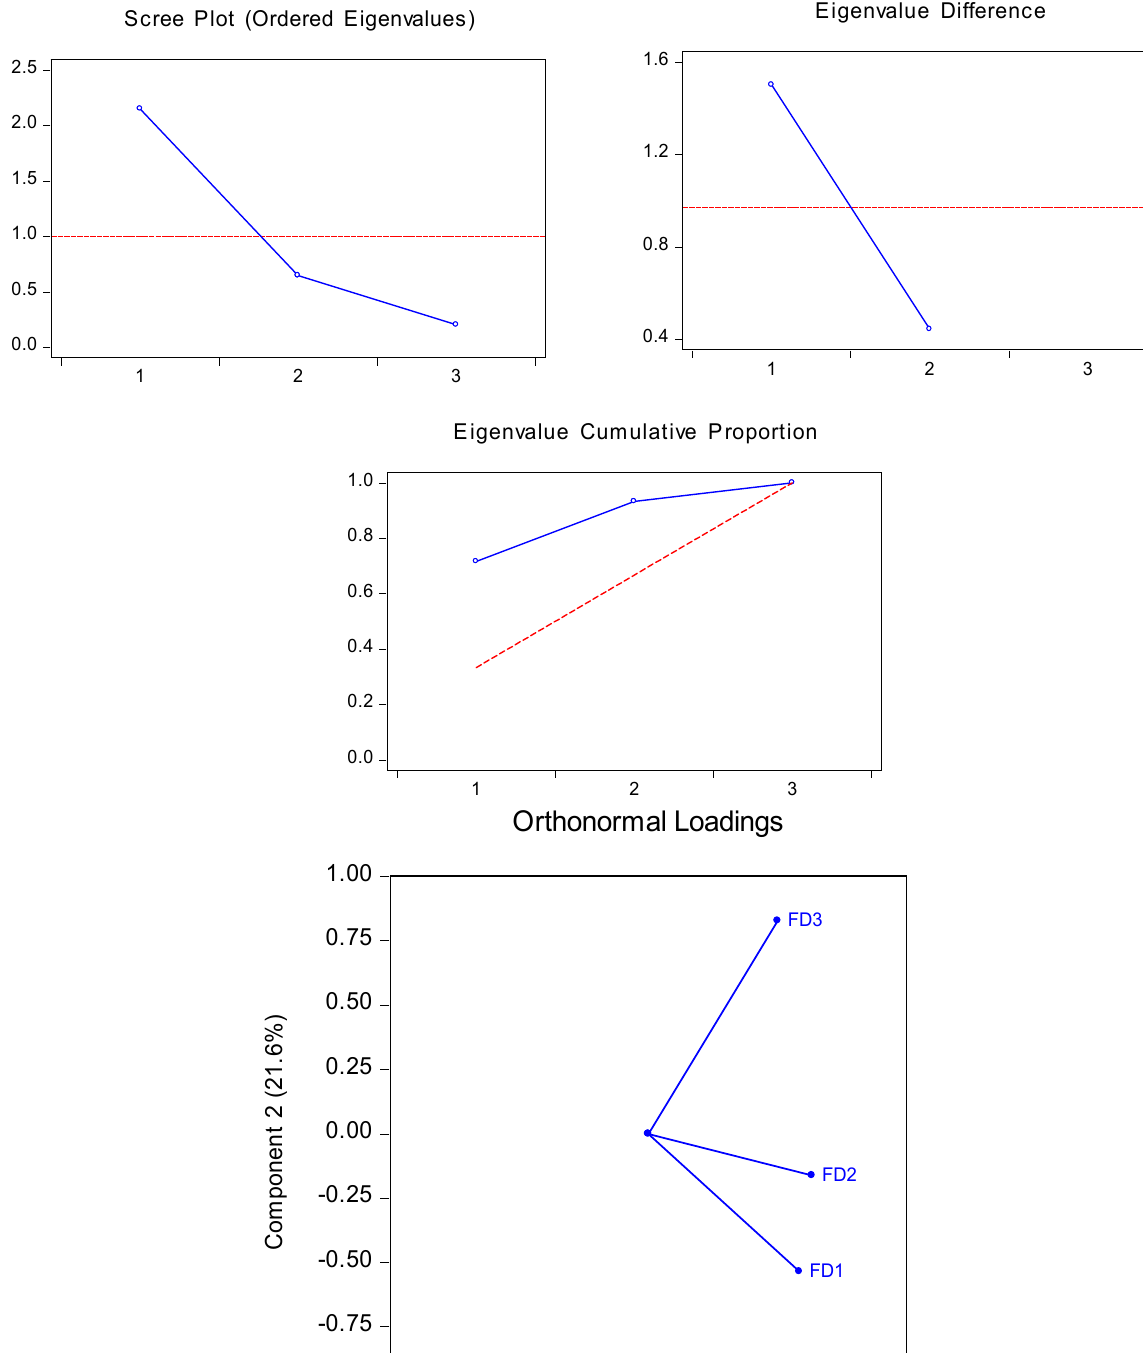
The scree plot shows the ordered eigenvalue, which shows that only a single FINDEX